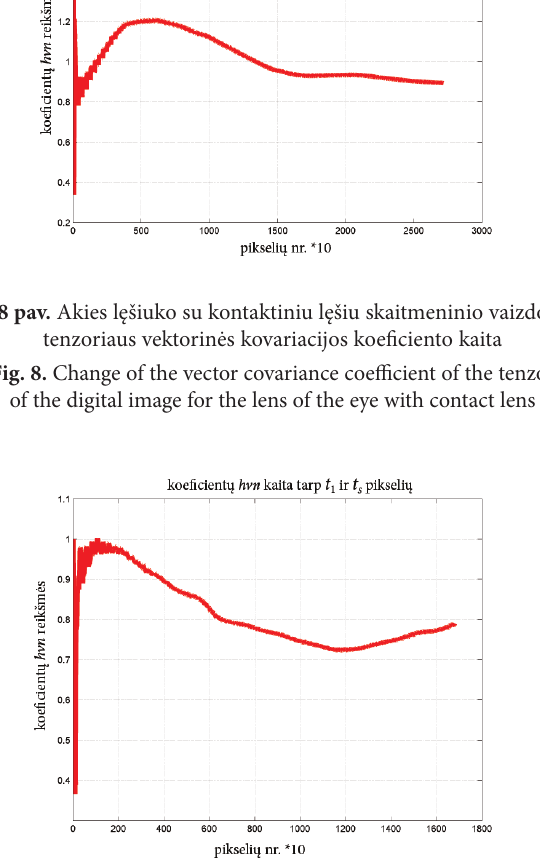
Fig. 9. Change of the vector covariance coefficient of the tenzor of digital image for the lens of the eye without contact